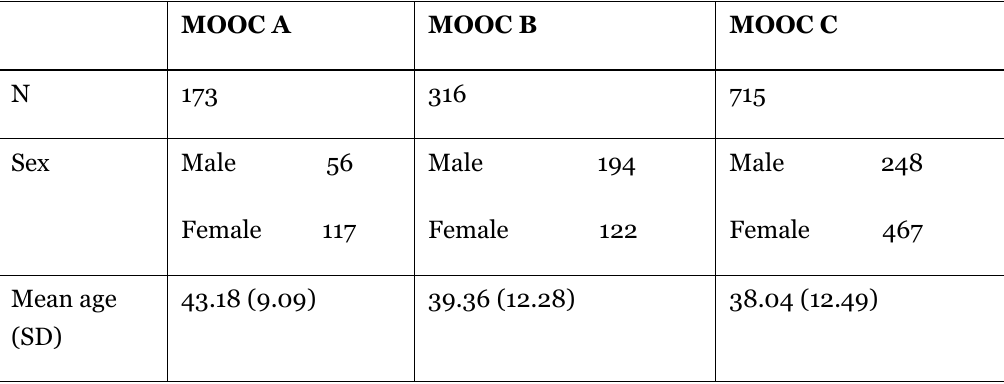
Summary of MOOC Takers Characteristics